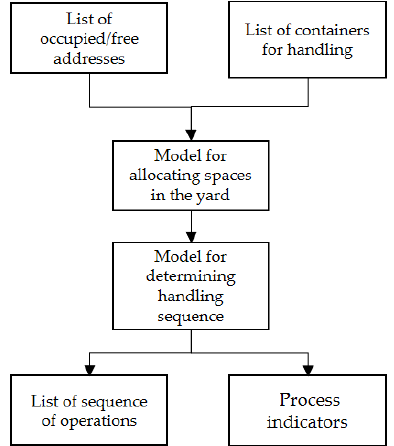
Figure 5. Model of assigning operations in container handling.